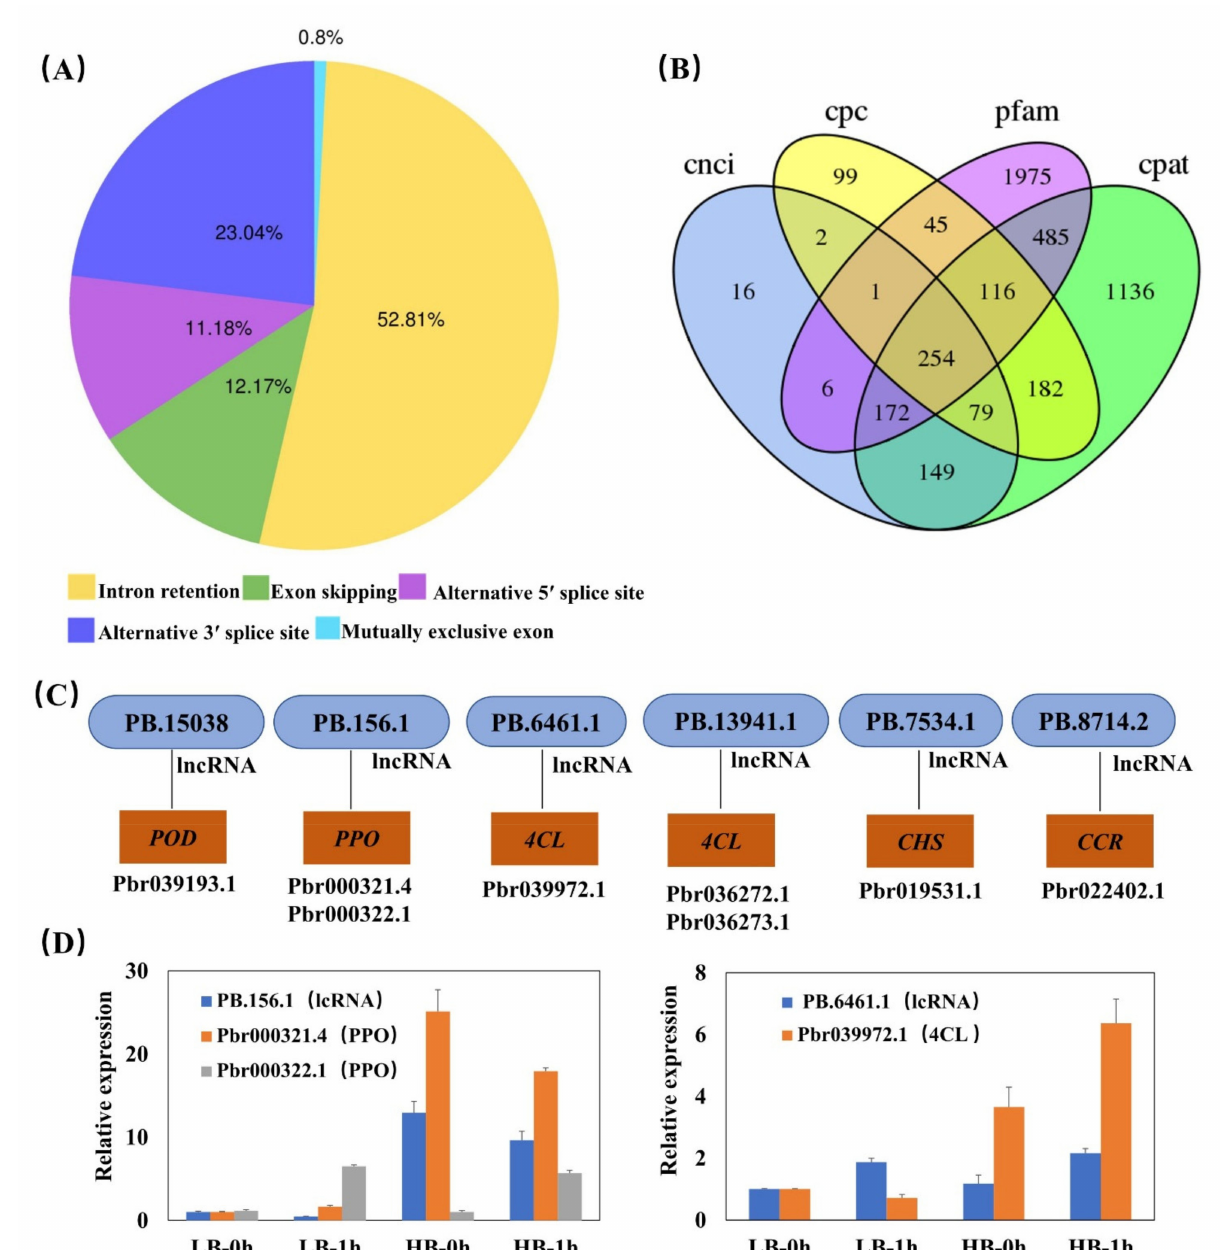
Figure 2. Identification of sand pear fruit alternative splicing (AS) and long noncoding RNAs (lncRNAs). ( A ) Number and categories of AS events based on the PacBio platform. ( B ) Number of lncRNAs analyzed by CNCI, CPC, Pfam, and CPAT based on the PacBio platform. ( C ) The lncRNA–mRNA regulatory network related to sand pear flesh enzymatic browning. ( D ) The expression level of lncRNAs and target genes by